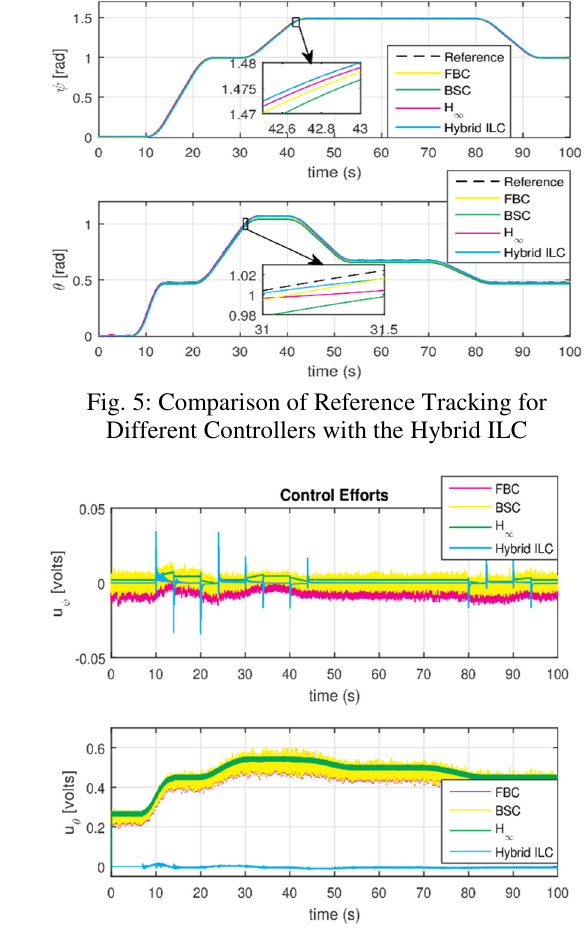
Fig. 6: Comparison of Control Efforts Using Different Controllers with the Hybrid ILC